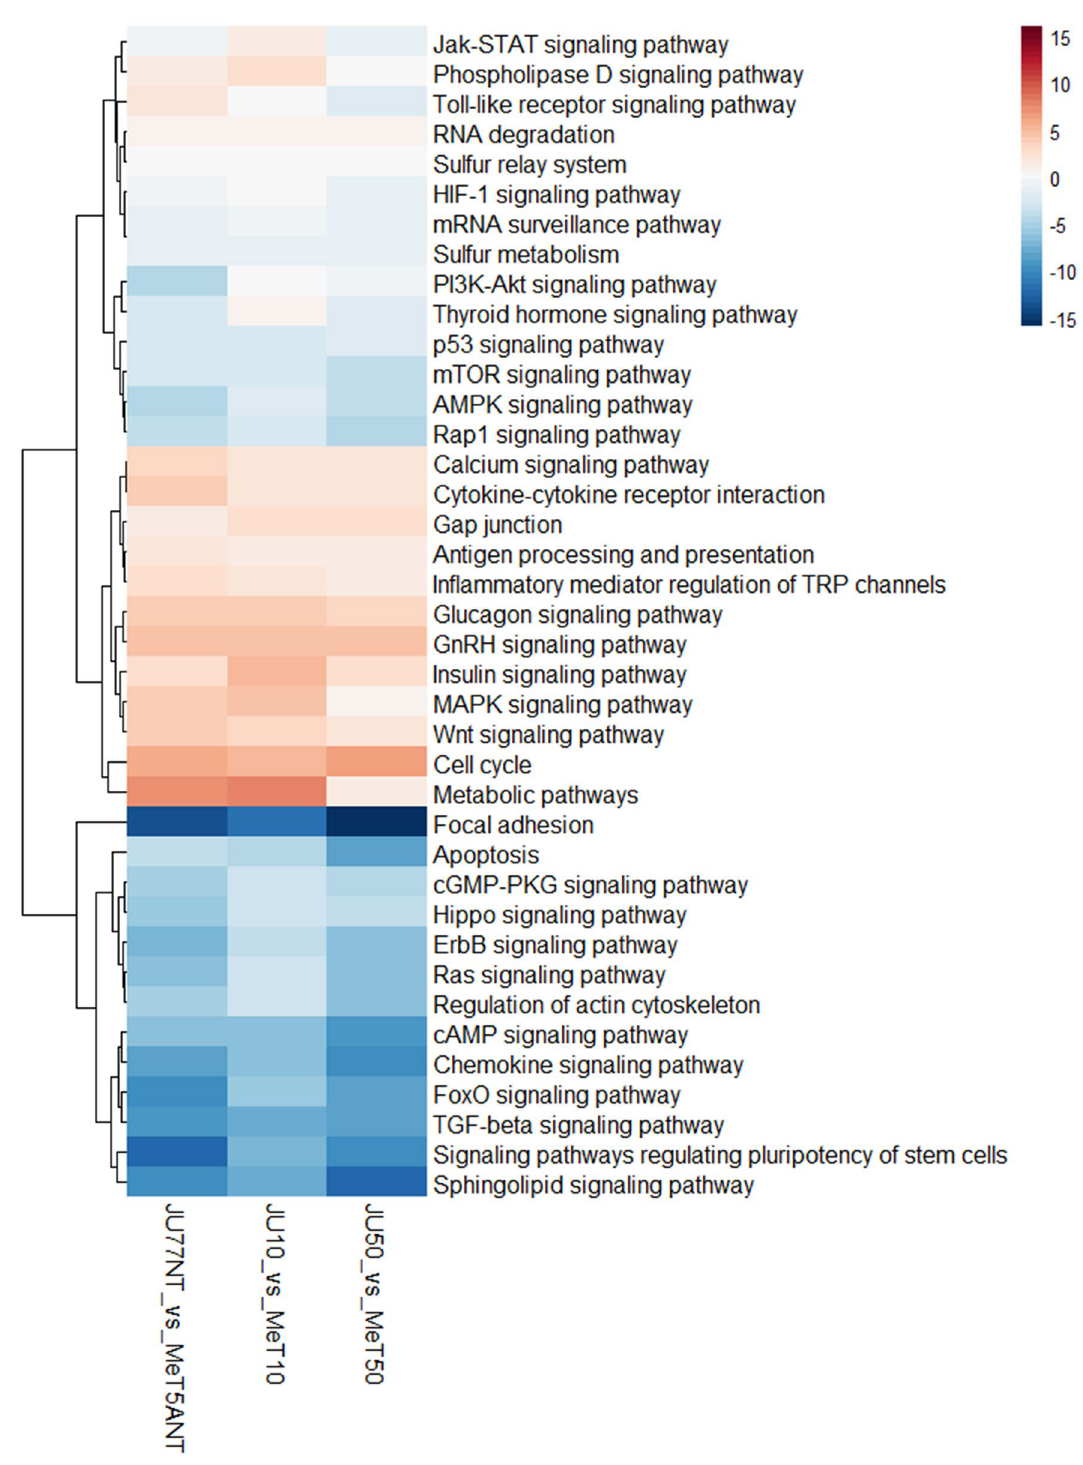
Figure 5. Heatmap showing the dysregulated pathways in JU77 (human malignant mesothelioma) vs. MeT-5A (human normal mesothelium) at the same concentration of FE fibers exposure by taking into account the differentially expressed